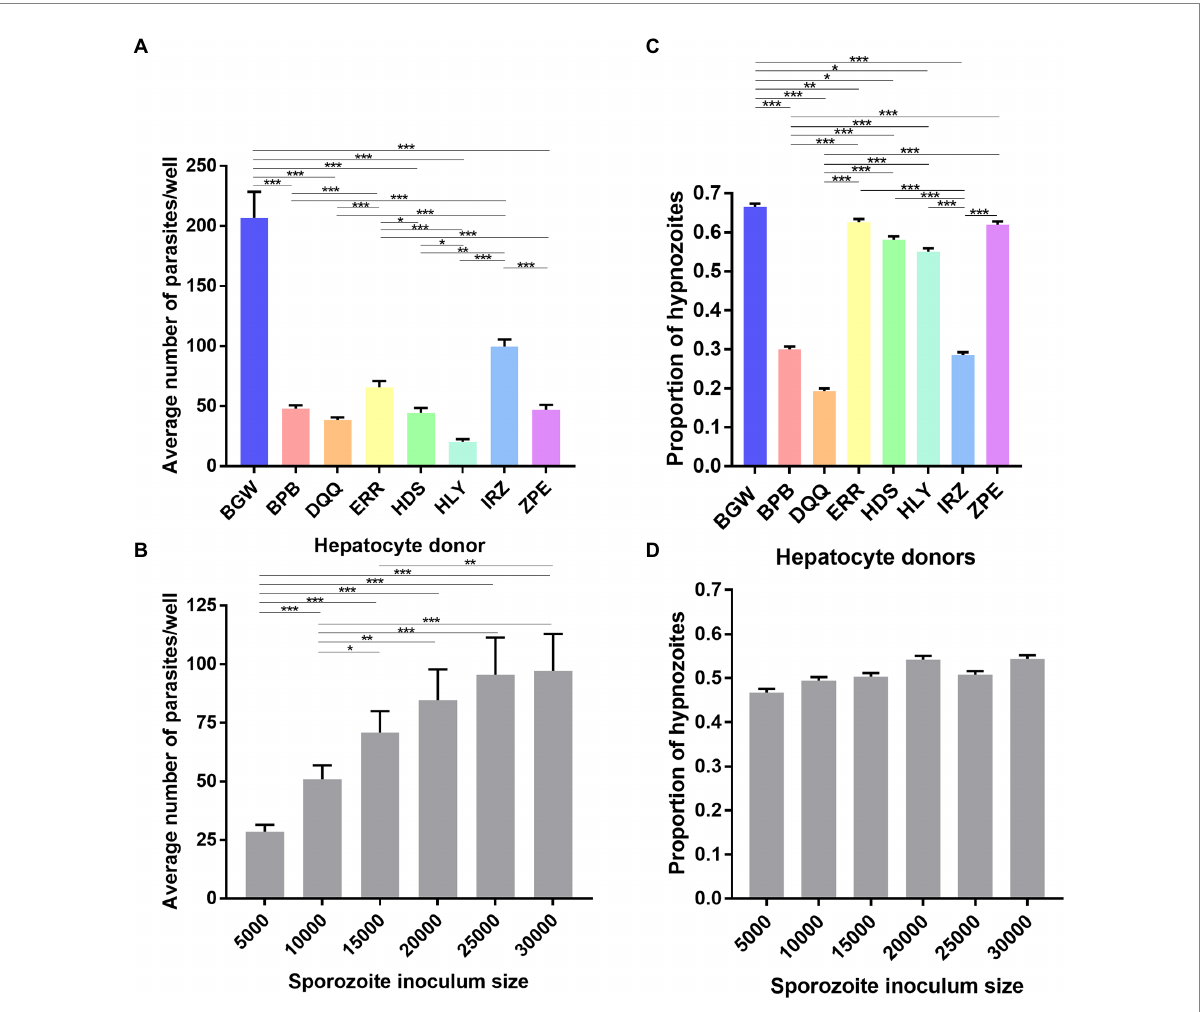
FIGURE 4 Growth metrics of liver-stage parasites following infection of eight PHH donor lots with one P. vivax case. Data include all parasites quantified from Experiment 2 in which eight PHH donor lots (BGW, BPB, DQQ, ERR, HDS, HLY, IRZ, ZPE) were infected with one P. vivax case at six sporozoite densities ranging from 5 × 10 3 to 30 × 10 3 per well. The average number P. vivax parasites per well is shown categorized by (A) PHH donor lot and (B) sporozoite inoculum size. The average proportion of P. vivax hypnozoites per well is shown categorized by (C) PHH donor lots and (D) sporozoite inoculum size. Asterisks indicate significant differences ( Post hoc Tukey’s pairwise comparisons, *** p < 0.0001, ** p < 0.001, * p < 0.05). Bars represent ± SE (A,B) or ± 95% CI (C,D)